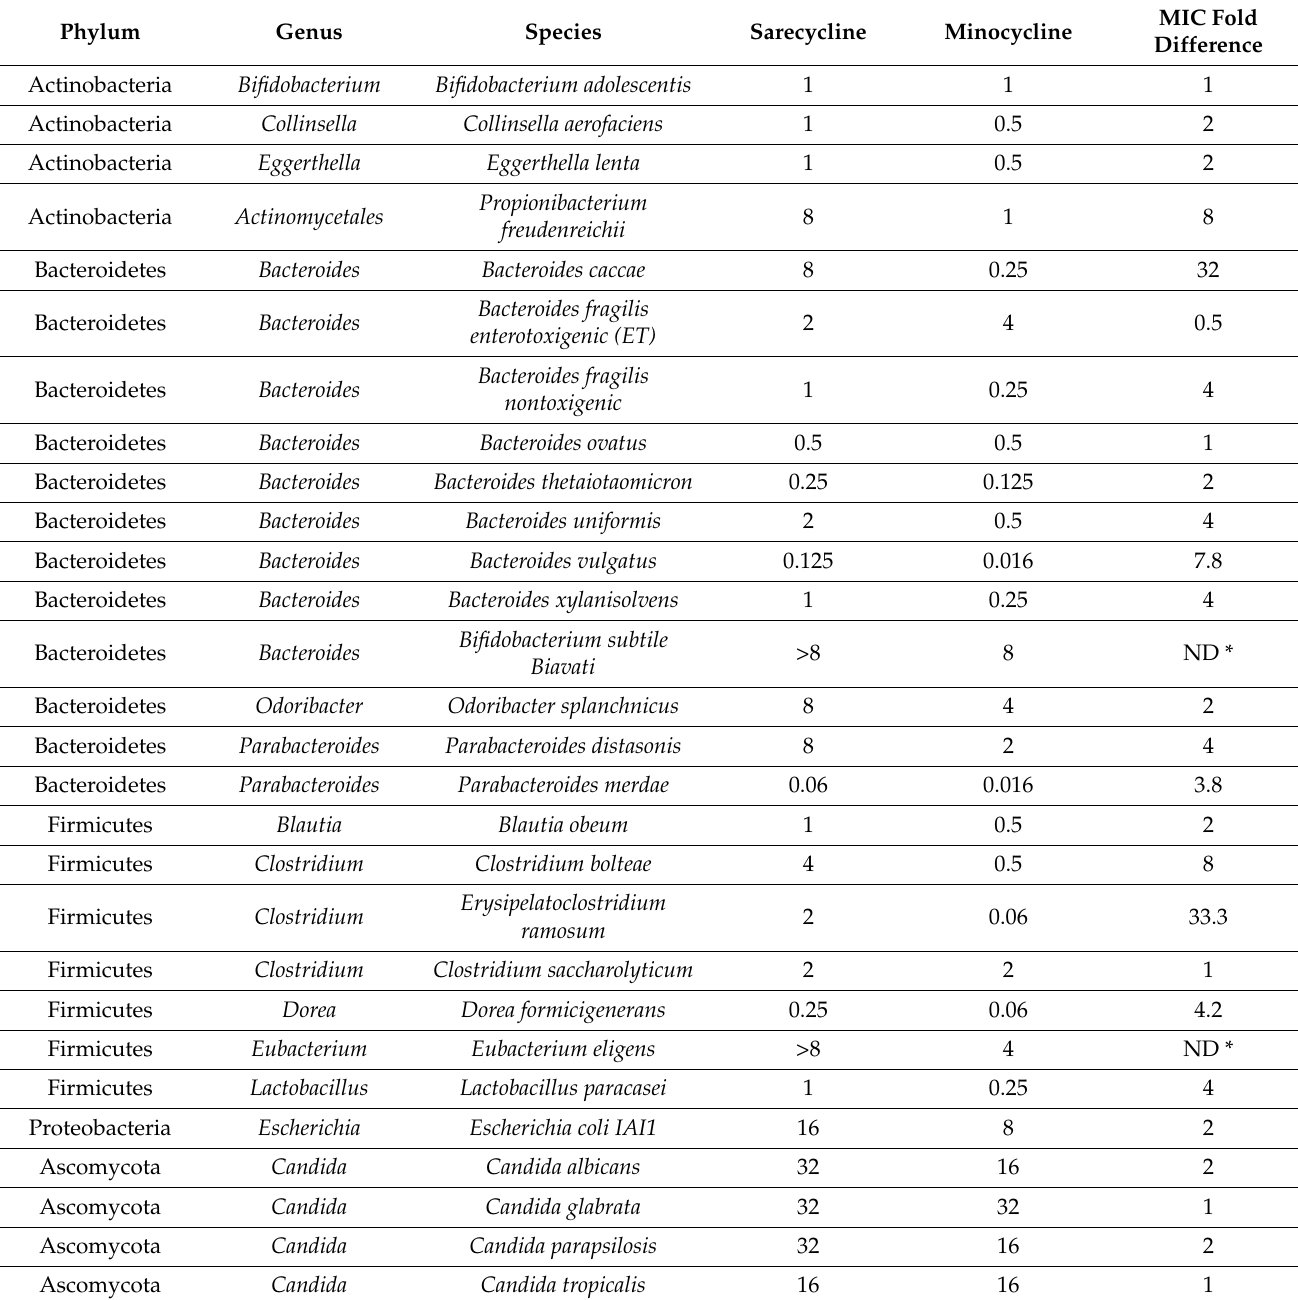
Table 1. Susceptibility testing results for sarecycline and minocycline against the strains tested in µ g/mL ( n =